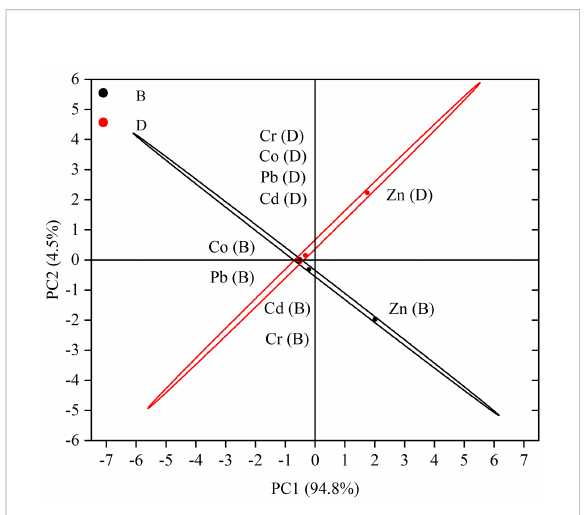
FIGURE 6 The principal component analysis loading plot of the dissolved trace metals in the B) surface seawater and D) bottom